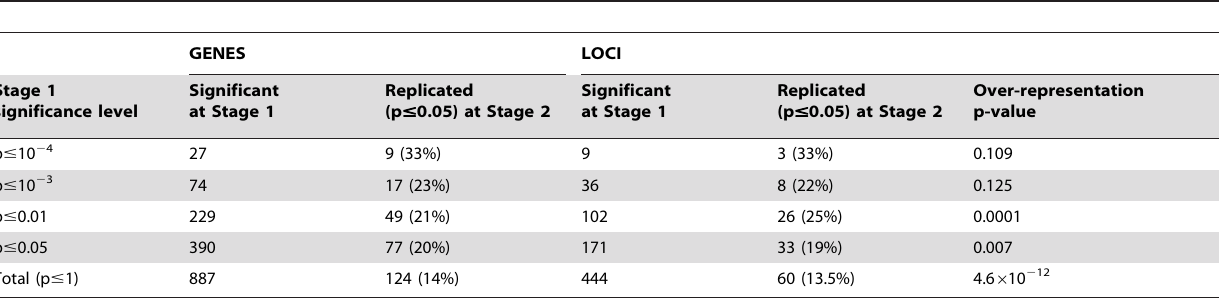
Table 1. Overrepresentation of replication of significant genes/loci available at Stage 2, excluding all loci of 0.5 Mb around genes previously reported[4–8] and Stage 1 IGAP genes[9,19] containing genome-wide significant SNPs.